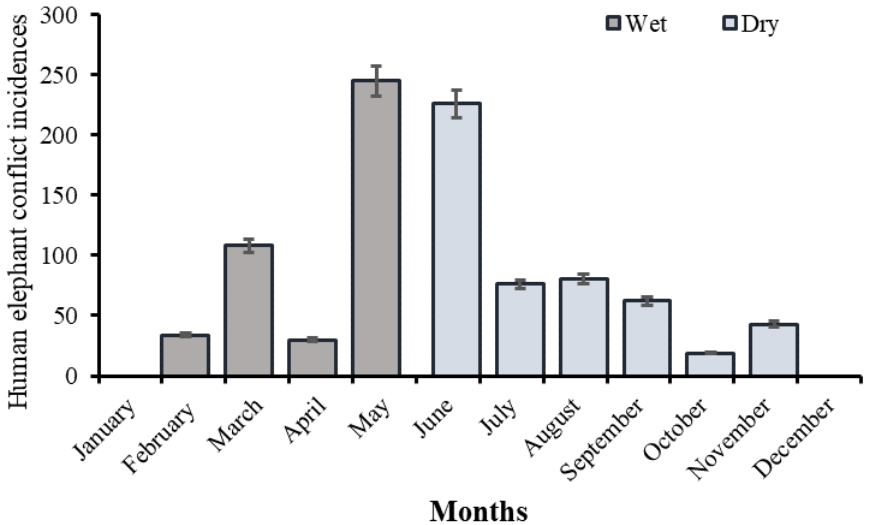
Figure A4. Temporal distribution of average ( ± SE) human elephant conflict (HEC) incidences